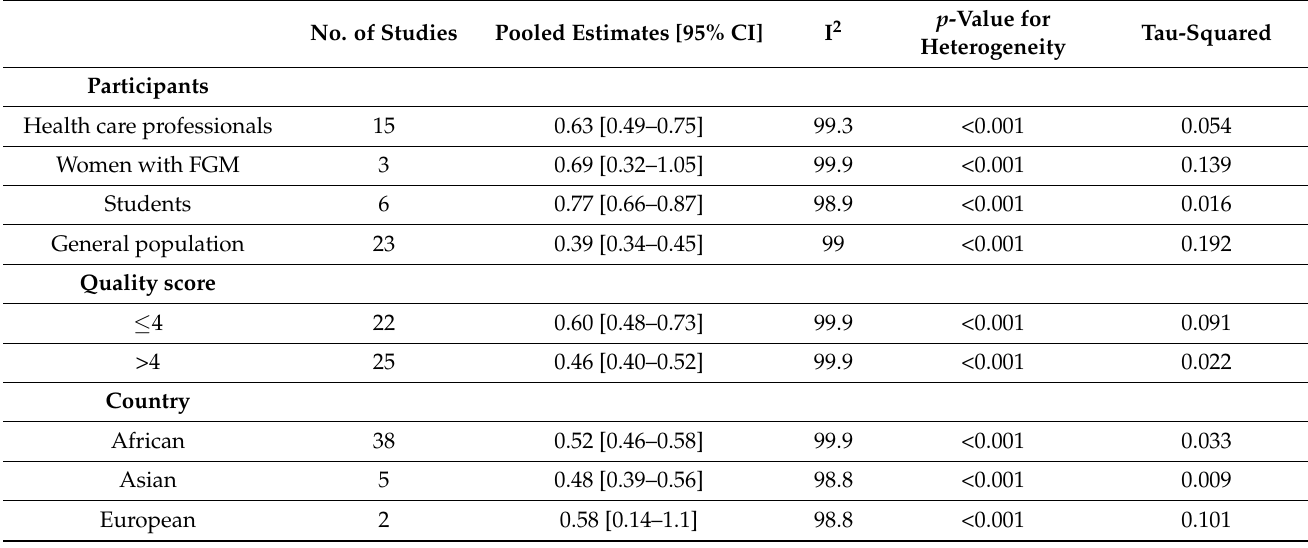
Table 2. Findings of the subgroup analyses of negative attitudes toward FGM.